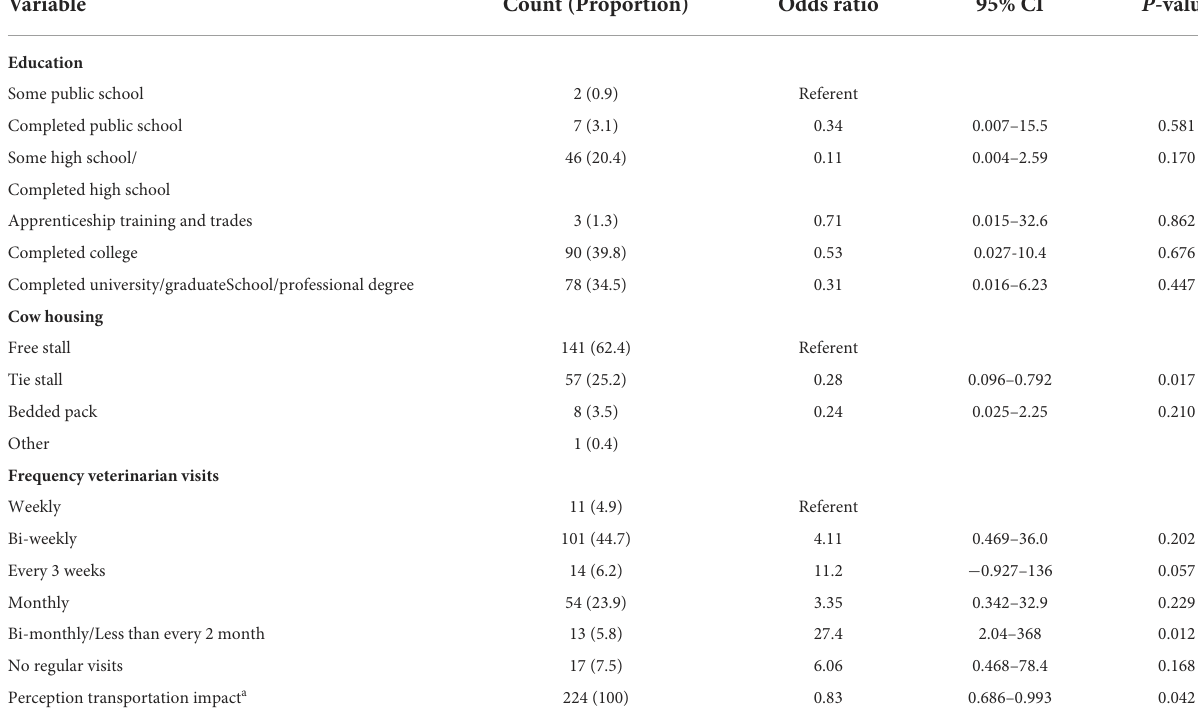
TABLE 2 Final multivariable logistic regression model evaluating variables associated with the odds of complying with proAction requirements of having a cull cow standard operating procedure among 226 respondents. Variable Count